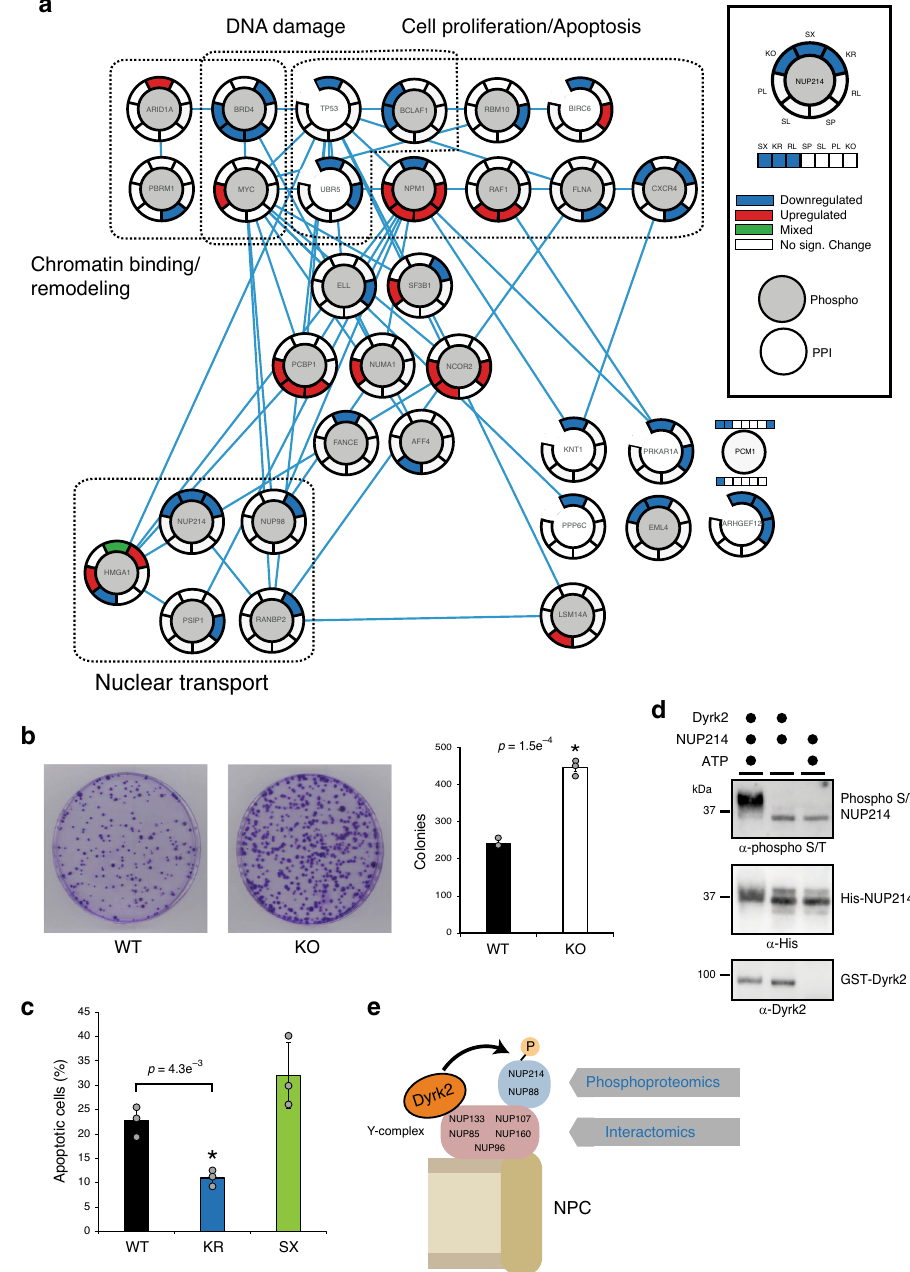
Fig. 8 Impact of Dyrk2 mutations on the network of known cancer driver proteins. a Network of cancer driver proteins (Cancer Gene Census) found to be signi fi cantly regulated either at the phospho level (|log2FC | > 1, adj. p -value ≤ 0.05) and/or at the interactome level (|log2FC| > 1, adj. p -value < 0.05). The statistical analysis and p -value calculation (adj. p -value (FDR)) was either performed within the mapDIA package (phosphodata) or with two-tailed unpaired Student ’ s t -test and p -values were adjusted using the method of Benjamini – Hochberg 67 (interaction data). The network is based on reported interactions between the proteins (IID v.2018-05; only experimentally validated interactions). The gene ontology analysis was performed with DAVID and signi fi cant terms ( p -values < 0.05) were merged in general terms ( “ Methods ” section). The regulation of the interaction and phosphorylation of cancer driver proteins by Dyrk2 mutants is illustrated with a color code. For PCM1 the lower color code shows the regulation on interactome level, the upper color code shows the regulation on phosphorylation level. b Colony formation assay of CRISPR/Cas9 engineered T-REx-HeLa DYRK2 KO cells. c Annexin V-FITC apoptosis assay of MDA-MB-213 cells overexpressing Dyrk2 wt or Dyrk2 KR and Dyrk2 SX, respectively. d In vitro phosphorylation assay using recombinant Dyrk2 and NUP214 (Ser601-Arg868) incubated for 1 h at 37 °C. Phosphorylation was detected by an anti-phospho-serine/threonine antibody. The experiment was repeated independently ( n = 2) with similar results. e Model of the putative function of Dyrk2 at the nuclear pore complex (NPC). As shown by BioID – MS Dyrk2 interacts with subunits of the nuclear Y-complex. Quantitative phosphoproteomic analysis revealed a Dyrk2-dependent phosphorylation of NUP214 and NUP88, which represent direct interaction partners of the Y-complex. Error bars represent the mean value (center) with 95% con fi dence interval ( n = 3 biologically independent experiments). Statistical analysis was performed with two-tailed unpaired Student ’ s t -test. The asterisk indicates a signi fi cant statistical difference ( p -value ≤ 0.05). Source data are provided as source data fi